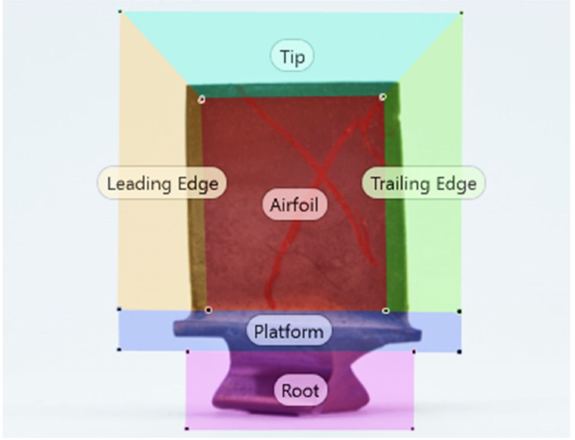
Figure 28. Blade with areas of interest